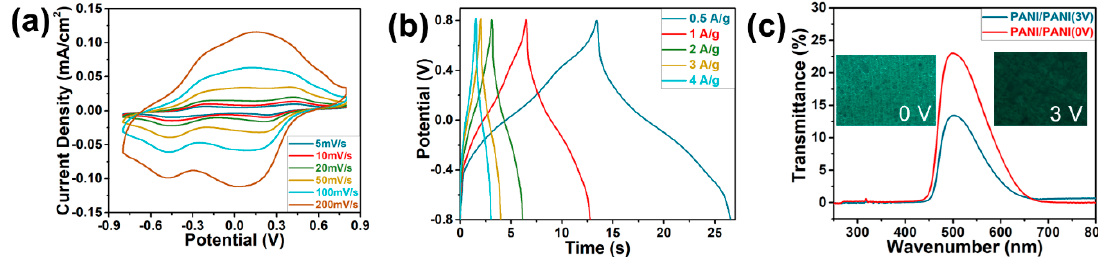
Figure 5. The electrochemical and electrochromic properties of the symmetric ESCs. ( a ) CV curves for the symmetric ESC at 5–200 mV/s; ( b ) GCD curves for the symmetric ESCs at 0.5–5 A/g; ( c ) UV–vis spectra and digital photographs for the symmetric ESC before and after electrification.